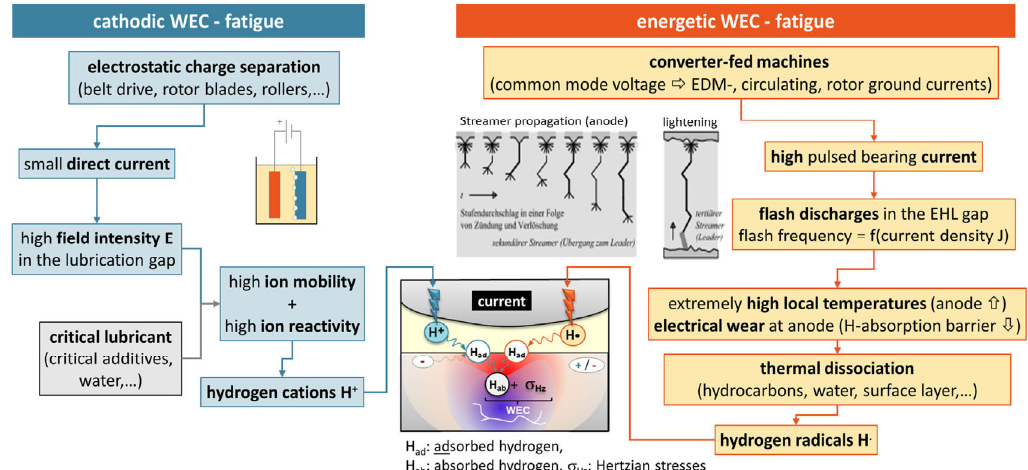
Fig. 26 Root cause hypothesis for WEC formation due to bearing currents [267]. Reproduced with permission from Ref. [267], © Society of Tribologists and Lubrication Engineers,